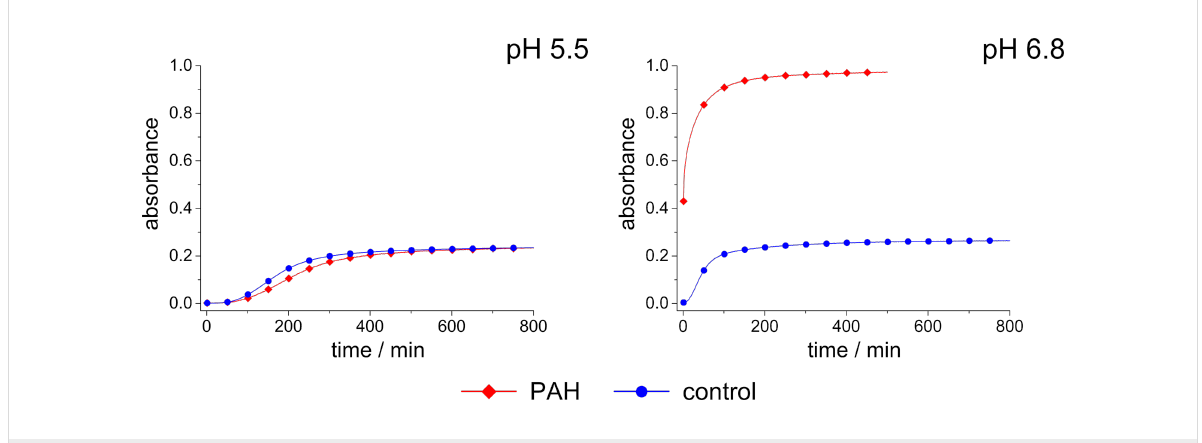
Figure 3: Absorbance of a 90 mM sodium metasilicate solution with 31.25 µM PAH (red rhombuses) and of a pure sodium metasilicate solution (control, blue circles) measured as a function of time up to 800 min.